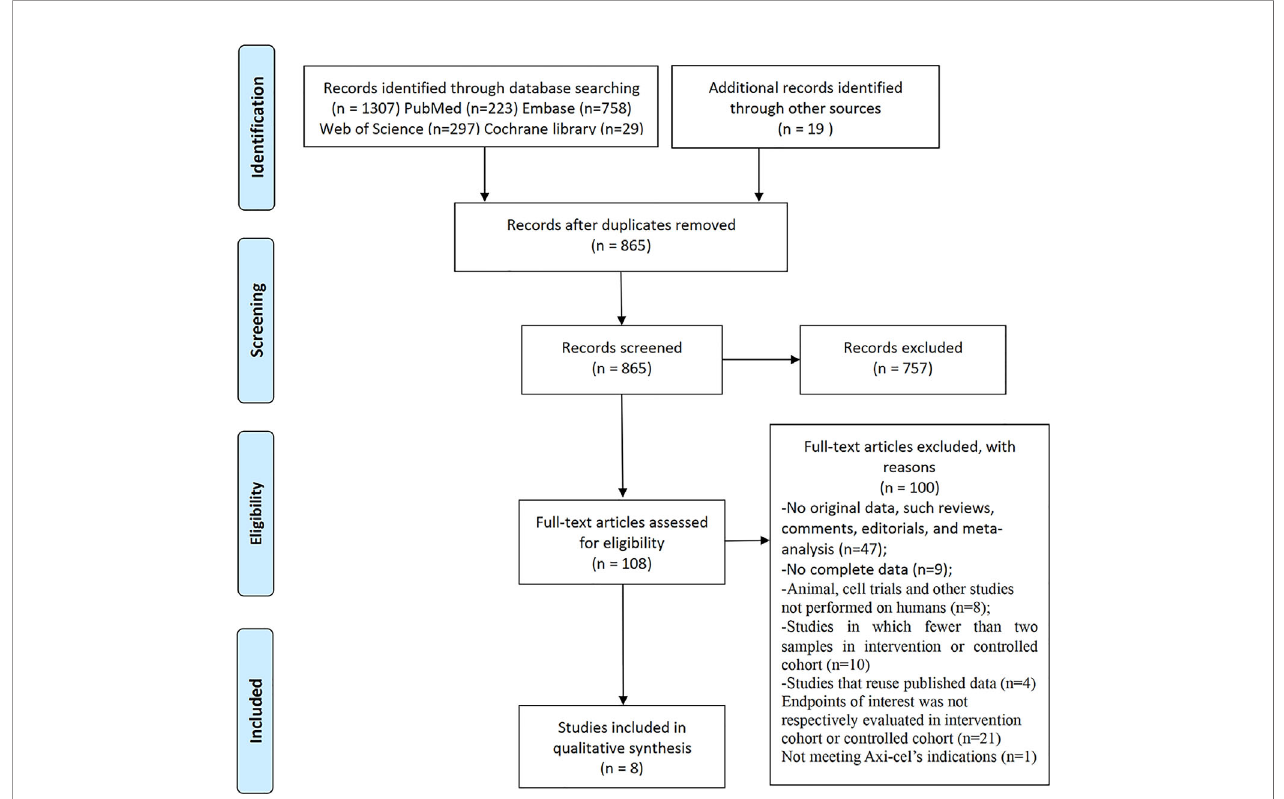
FIGURE 1 | Flow diagram of the study select